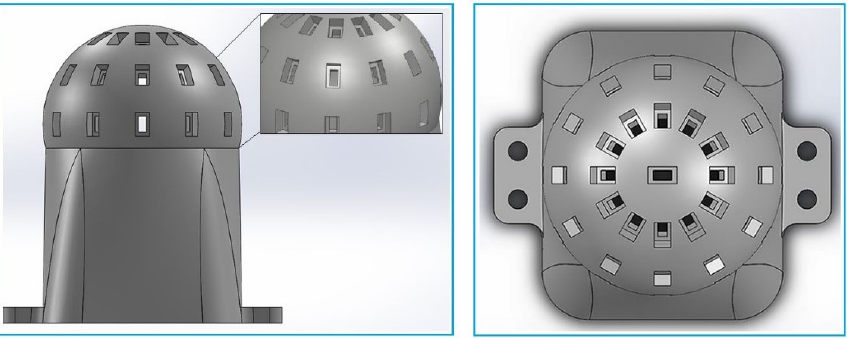
Figure 3. Sensor model front view (left), Sensor model top view (right).